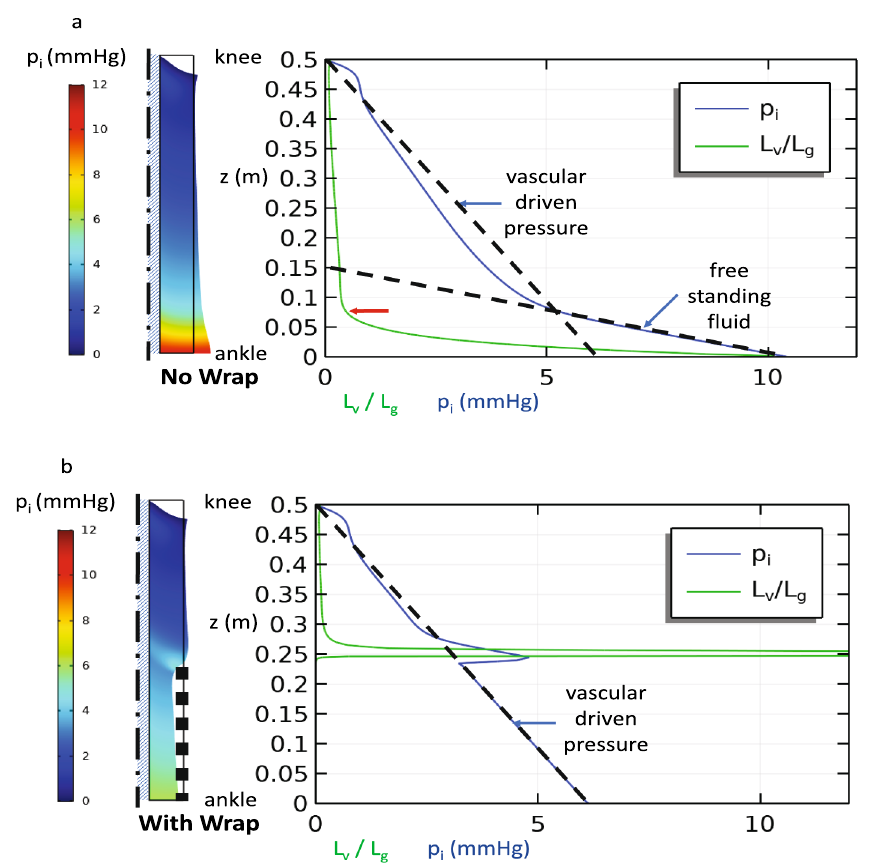
Figure 4. Steady state simulation with venous insufficiency in a single-layer model: p c = 10 mmHg + ρ g(h-z) and p L = −2 mmHg. Interstitial pressure along the outer surface and L v / L g ( a ) without and ( b ) with a compression wrap that imposes a radial pressure, but does not alter the capillary pressure by relieving venous insufficiency. The dashed lines show the pressure gradients expected due to a free-standing column of fluid and that due to a strictly local balance between the interstitial space and the vasculature. A transition from